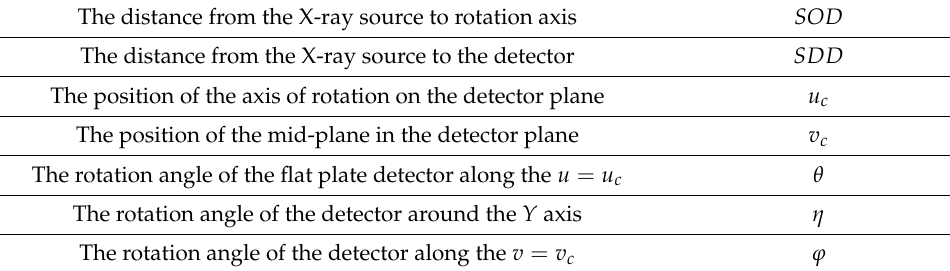
Figure 1. Geometric model of a laboratory nanotomography system. Table 1. Geometric parameters of nanotomography system.